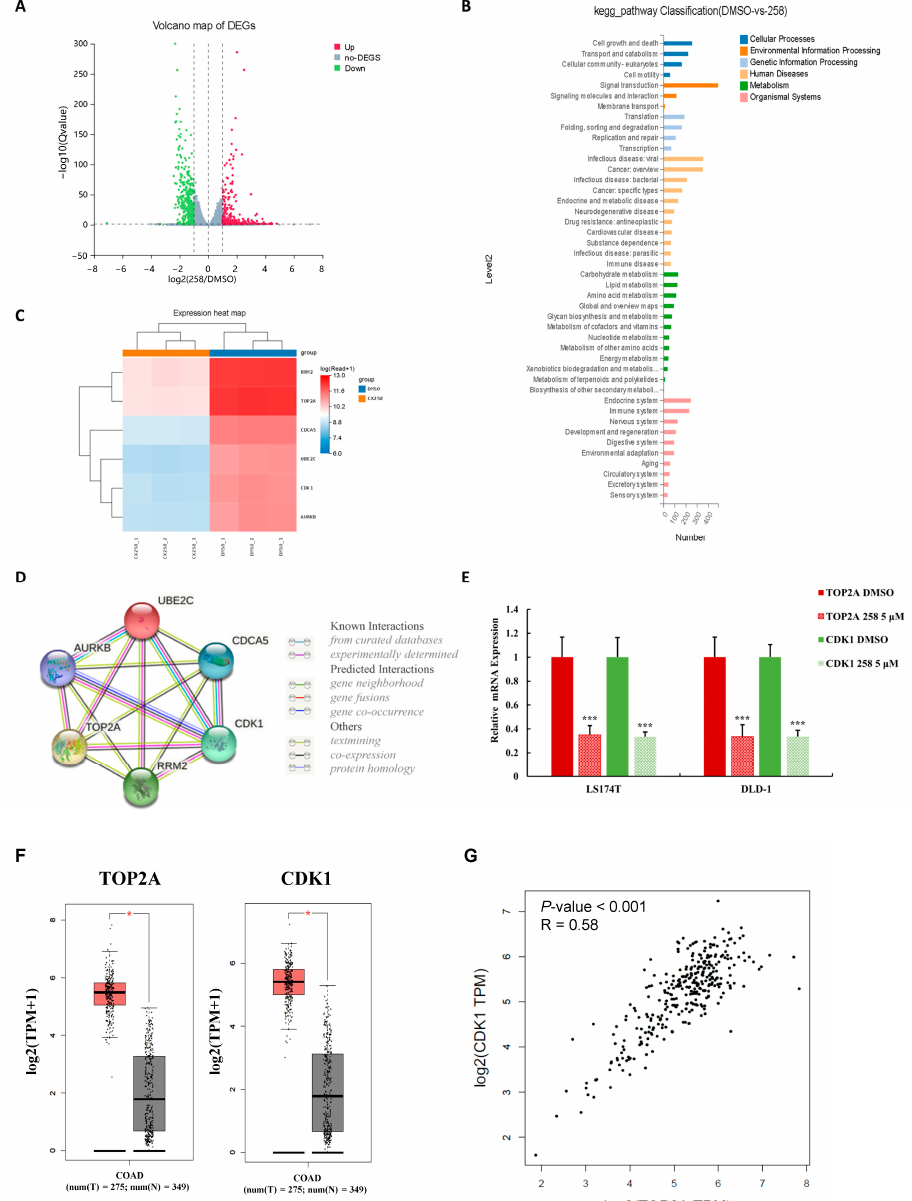
Figure 4. The effects of CX258 on the transcriptome of CRC cells. ( A ) Volcano map of differentially expressed genes (DEGs), including 2306 up-regulated and 2607 down-regulated mRNA. ( B ) KEGG pathway enrichment analysis of DEGs. ( C ) Heat map matrix of six selected DEGs. ( D ) Protein–protein interaction (PPI) network analysis of selected DEGs. ( E ) Quantitative RT-PCR (qRT-PCR) analysis. CX258 inhibited TOP2A and CDK1 mRNA expression in LS174T and DLD-1 cells. *** p < 0.001. ( F ) TOP2A and CDK1 were significantly overexpressed in CRC. TCGA colon adenocarcinoma tissue data (n = 275) and matched TCGA normal and GTEx data (n = 349) were analyzed using the GEPIA program (* p < 0.05). ( G ) Correlation of TOP2A and CDK1